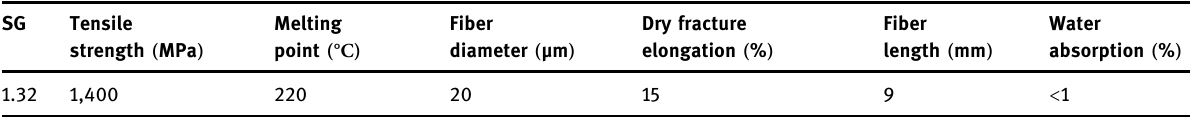
Table 2: Performance indices of PVA fi ber SG Tensile strength ( MPa